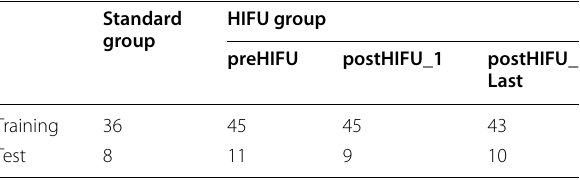
Table 2 Number of datasets in the training and test sets for the different